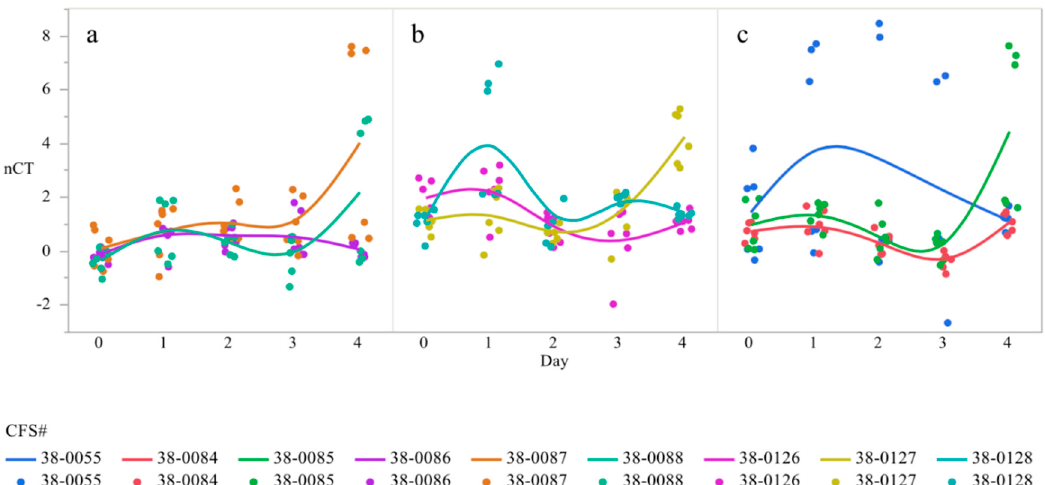
Figure 6. Differences in expression of the gene bcsA over time in strains of Salmonella Heidelberg ( a ), Enteritidis ( b ),and Kentucky ( c ) 1 . qRT-PCR was performed on total RNA isolated from bacterial cultures of Salmonella as pellicles were being formed over a 4-day time period 1 N = 90, n = 6, p < 0.0001 ( a ), 0.0222 ( b ), 0.0152 ( c ). Table 4. Changes in expression of the gene bcsA from planktonic cells used to form pellicles in Salmonella Kentucky, Enteritidis, and Heidelberg over a 4-day time period 1,2,3 . Day